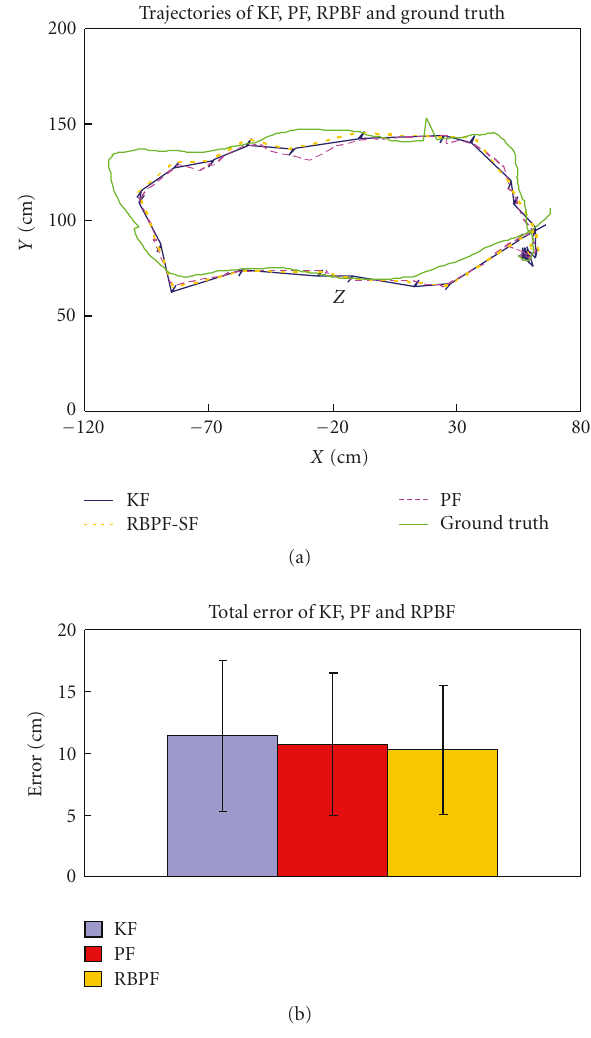
Figure 9: Performance comparisons among KF, PF, and RBPF-SF.